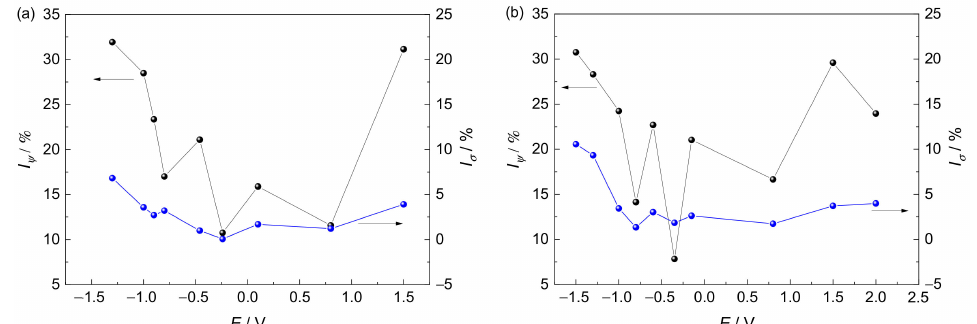
Figure 6. Reduction-in-area loss and fracture–stress loss at various potentials in simulated deep–sea ( a ) and shallow–sea ( b )